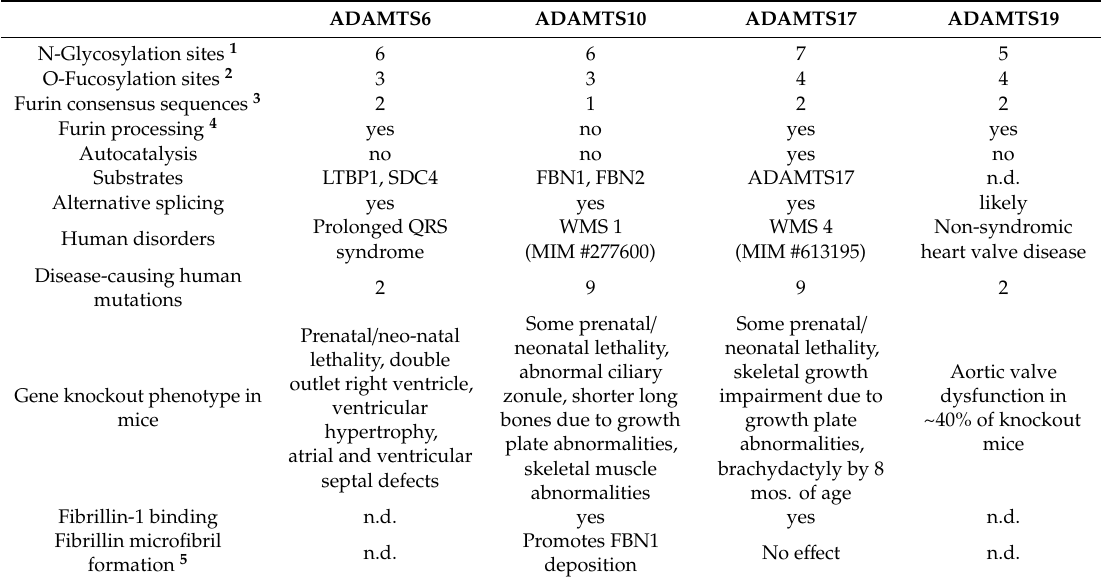
Table 1. Comparison of features distinguishing the individual ADAMTS6, 10, 17, and 19